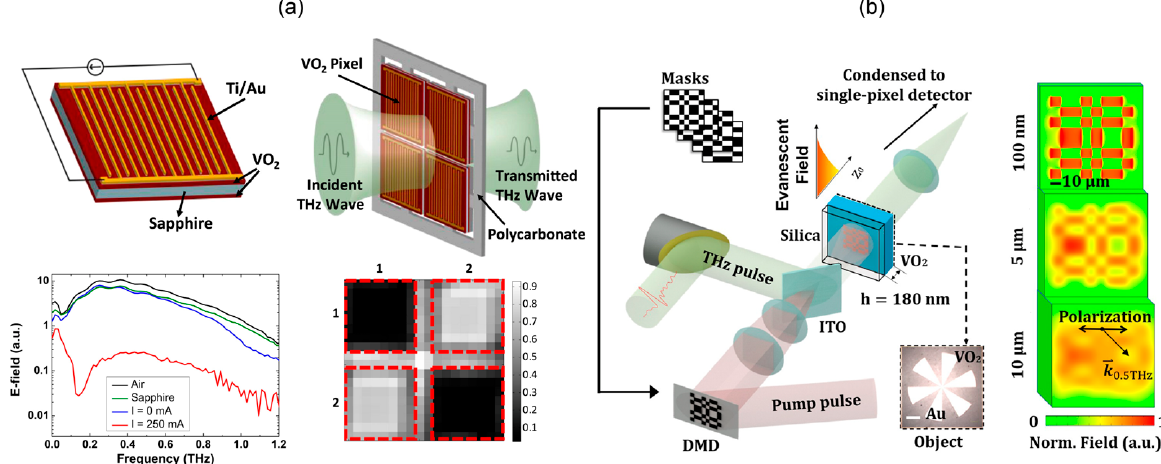
Figure 6. VO 2 -based THz SLMs. ( a ) Pixels made of double-layer VO 2 and interdigital electrodes, with their voltage-controlled transmittance and measured spatial pattern. Reproduced with permission from [76]. Copyright 2015 Elsevier B.V. ( b ) Femtosecond pumped VO 2 near-field SLM and the